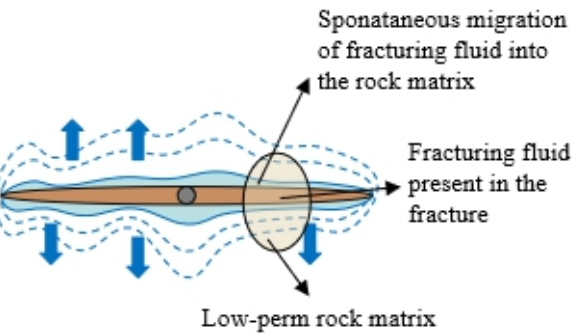
Figure 1. Schematic diagram of liquid phase entering crack and core matrix during fracturing.